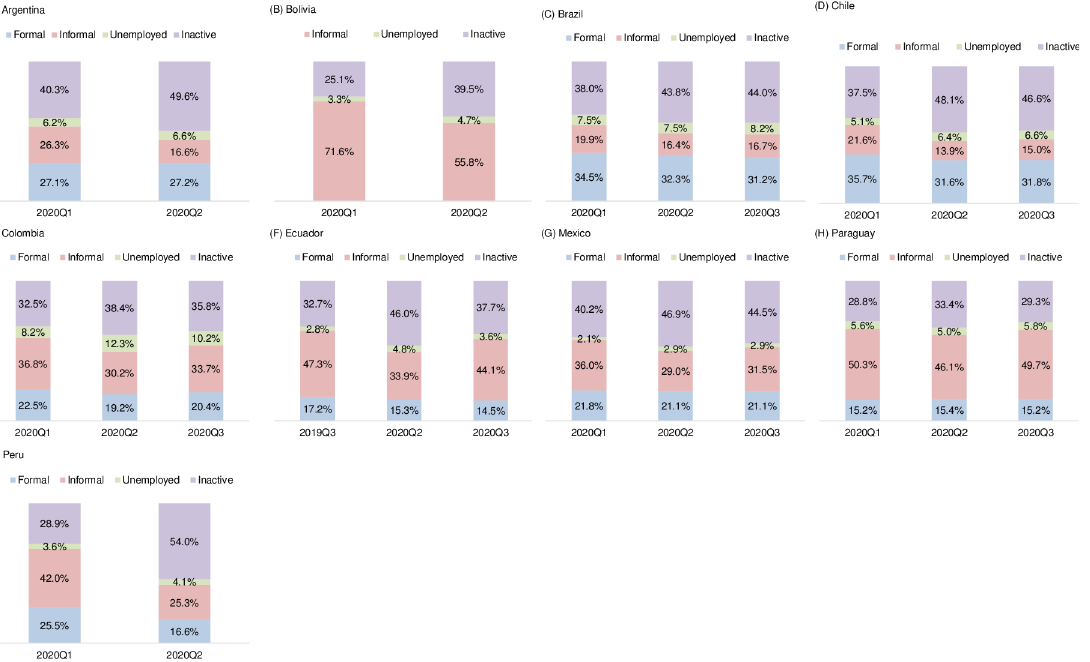
Fig 3. Distribution of the working-age population over 15 Years Old, selected Latin American countries, 2020 (percent). Sources: Estimates from household or employment surveys: Argentina—EPH (2020:Q1, Q2), Bolivia—ECH (2020:Q1, Q2), Brazil—PNADC (2020: Q1, Q2, Q3), Chile—ENE (2020:Q1, Q2, Q3), Colombia—GEIH (February, June, September 2020), Mexico—ENOE (2020:Q1, Q3) and ETOE (2020:Q2), Paraguay—EPHC (2020:Q1, Q2, Q3), Peru—ENAHO (2020:Q1, Q2). The EPH survey for Argentina only has urban coverage. For the second quarter, Bolivia’s ECH survey only reports a limited set of variables, so the formality variable cannot be constructed. For Ecuador, the 2019:Q3 survey is used because 2020:Q1 data are not